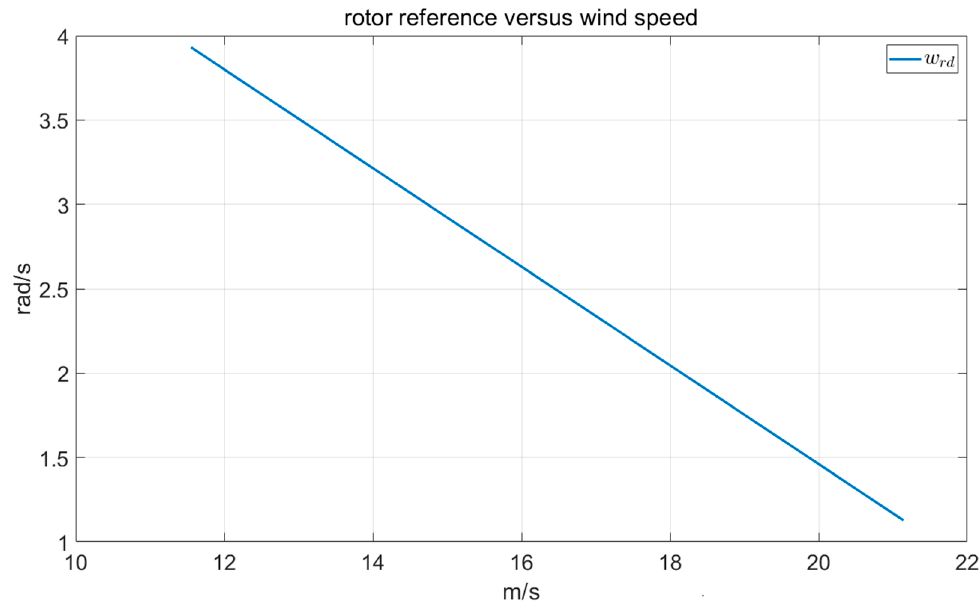
Figure 6. Reference of the rotor speed in region 3 of VWTs. Example 1. The CPSO approach .